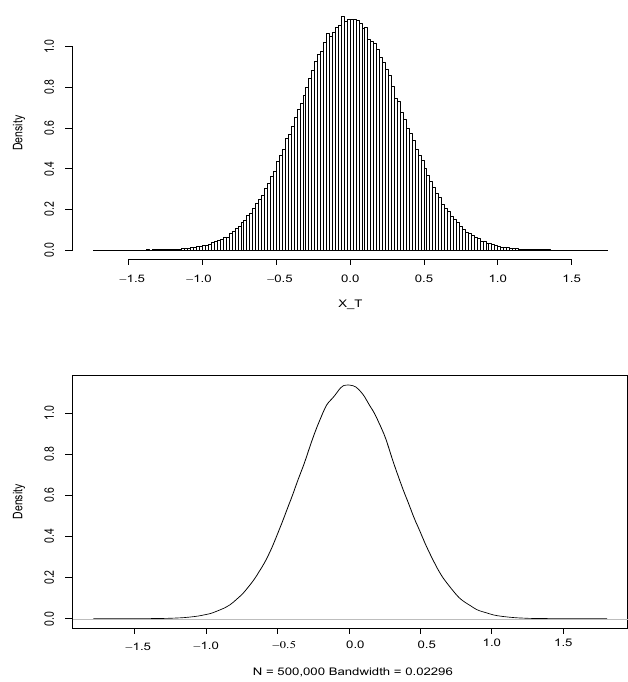
Figure 5. The empirical probability distribution of X T